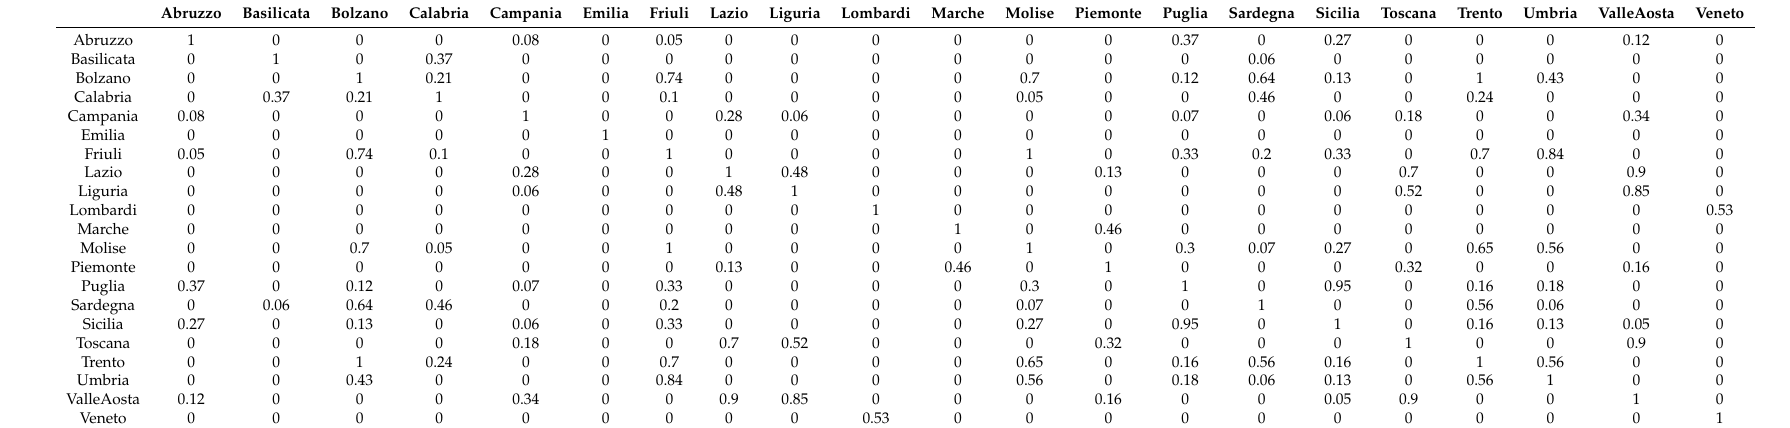
Table A15. Similarity values of Total Hospitalized network in the second week.